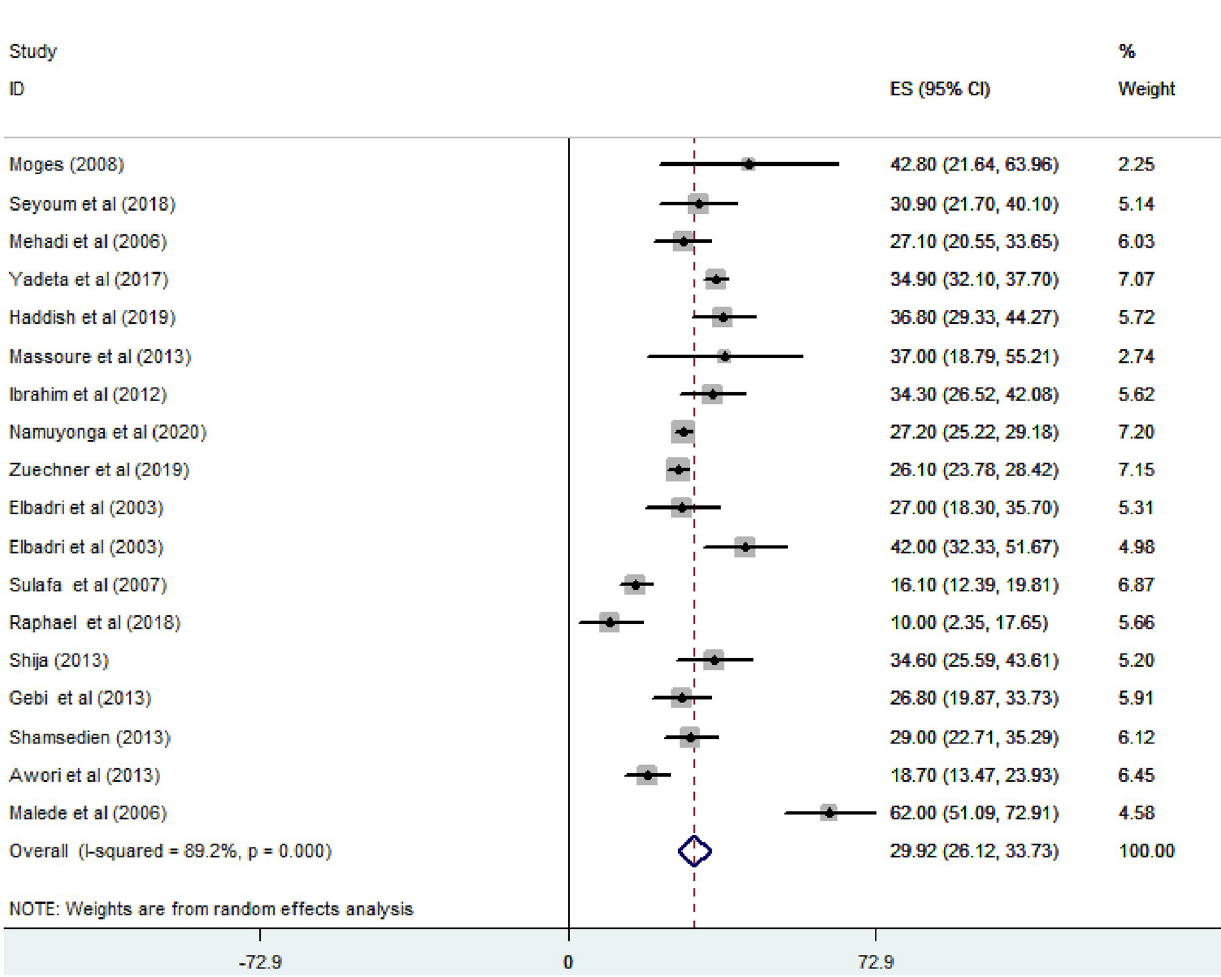
PLOS ONE | https://doi.org/10.1371/journal.pone.0250006 April 22,